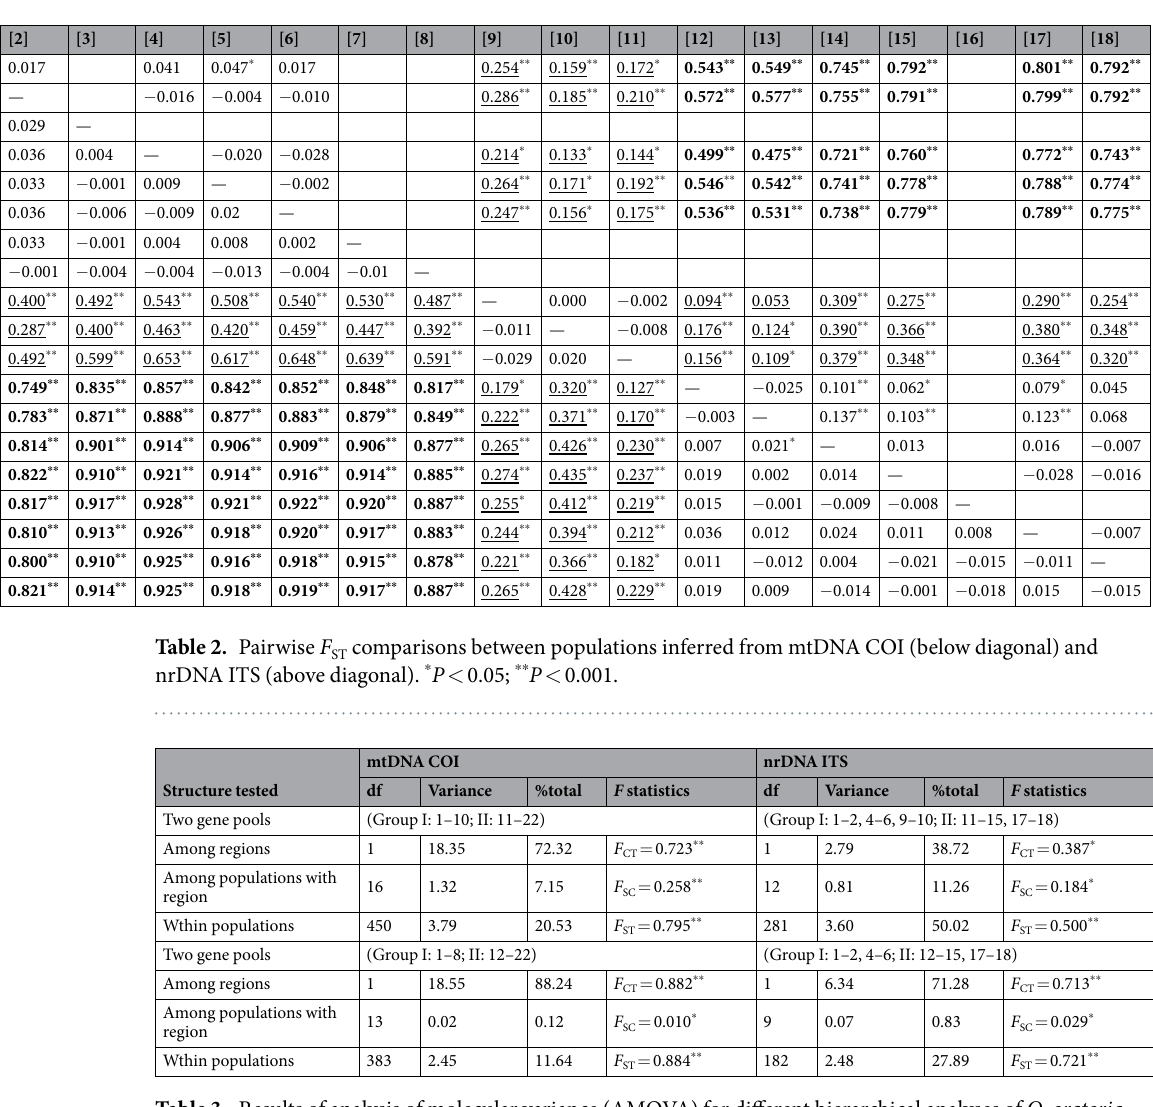
Table 3. Results of analysis of molecular variance (AMOVA) for different hierarchical analyses of O. oratoria populations. * P < 0.05; ** P < 0.001.